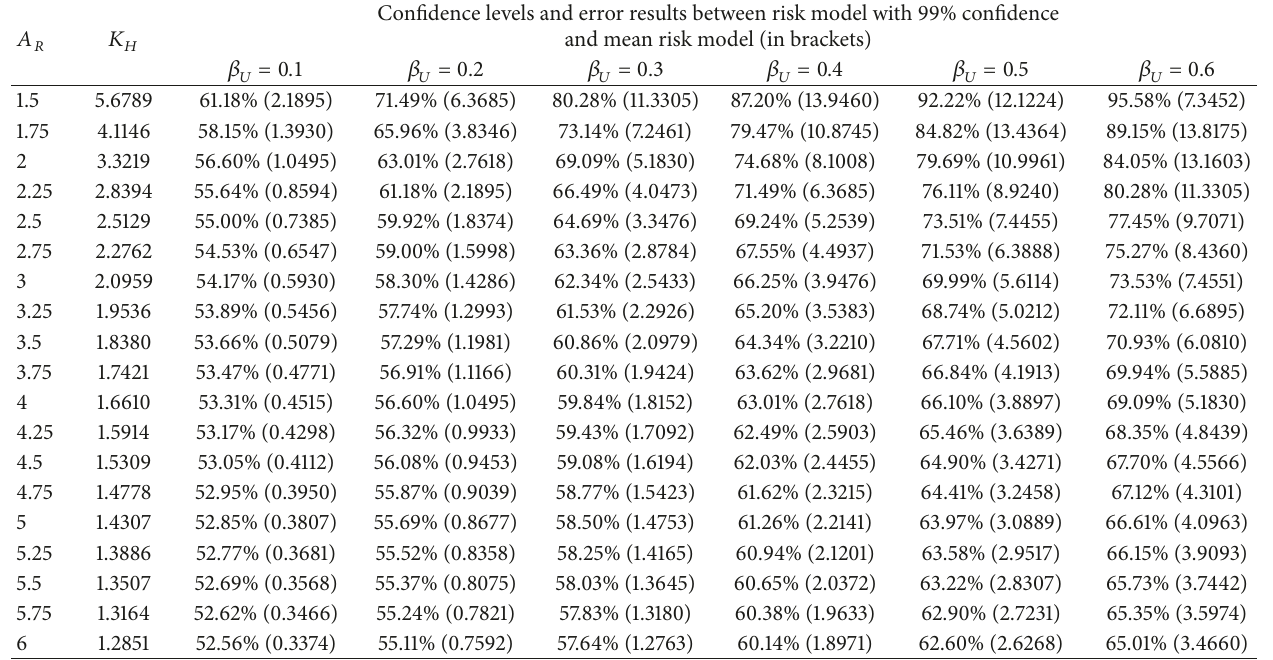
Table 1: Confidence levels and error values of mean seismic probability risk model for the usual range of 𝛽 𝑈 and 𝐾 𝐻 values.